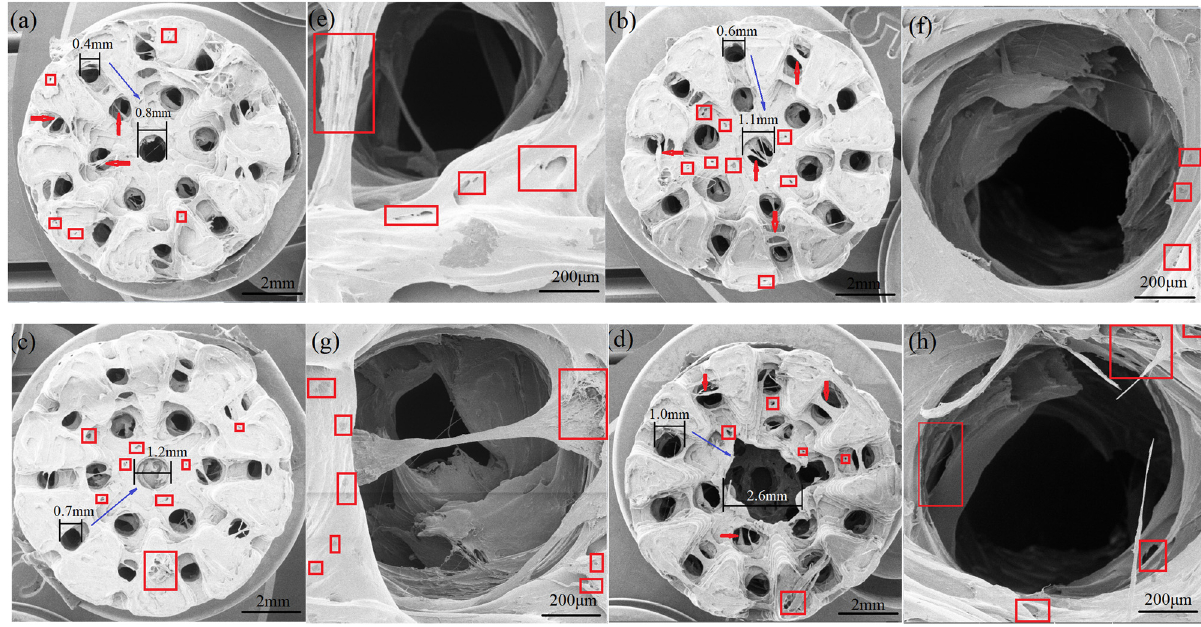
Figure 6: The surface morphology of PEEK scaffolds with pores gradual between: ( a ) 0.4 – 0.8 mm, ( b ) 0.6 – 1.0 mm, ( c ) 0.8 – 1.2 mm and (